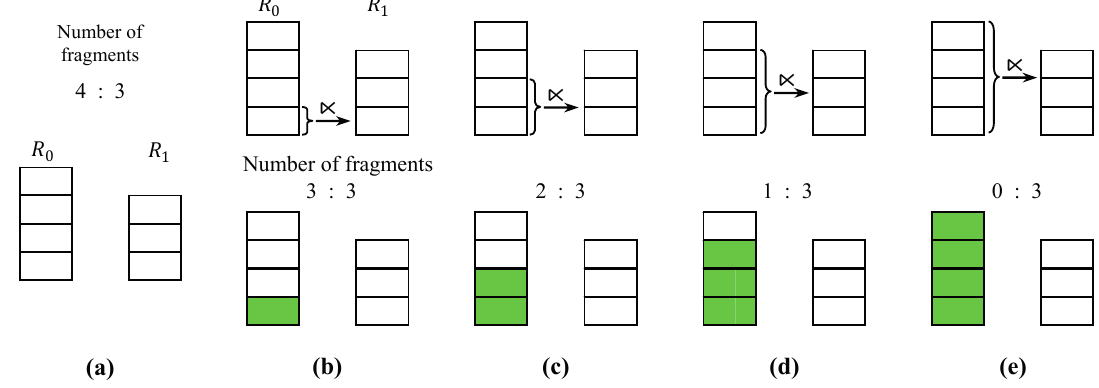
Figure 9. An Example of Optimization with Procedure opt (). ( a ) 4 and 3